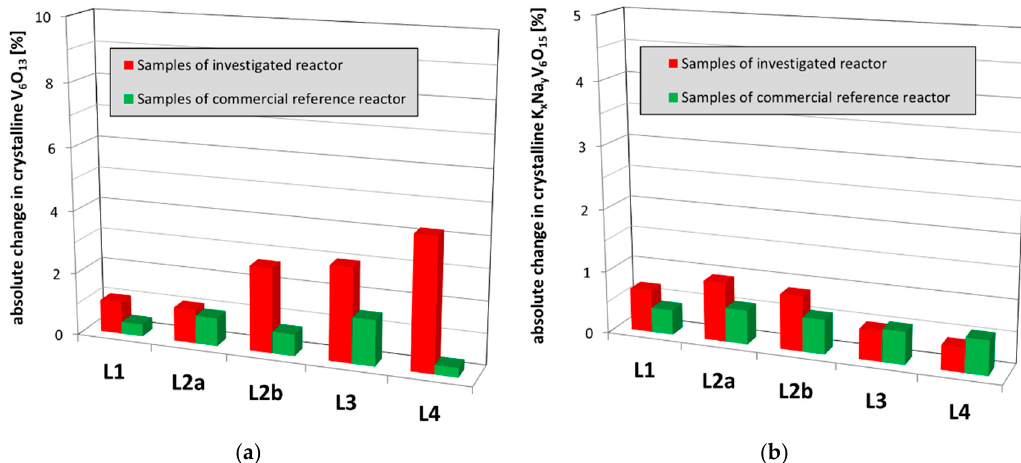
Figure 7. Comparison of the crystalline phase composition of used catalyst samples from the investigated reactor and the commercial reference reactor: ( a ) absolute changes in crystalline V 6 O 13 ; ( b ) absolute changes in crystalline K x Na y V 6 O 15 . The samples of each layer were averaged.